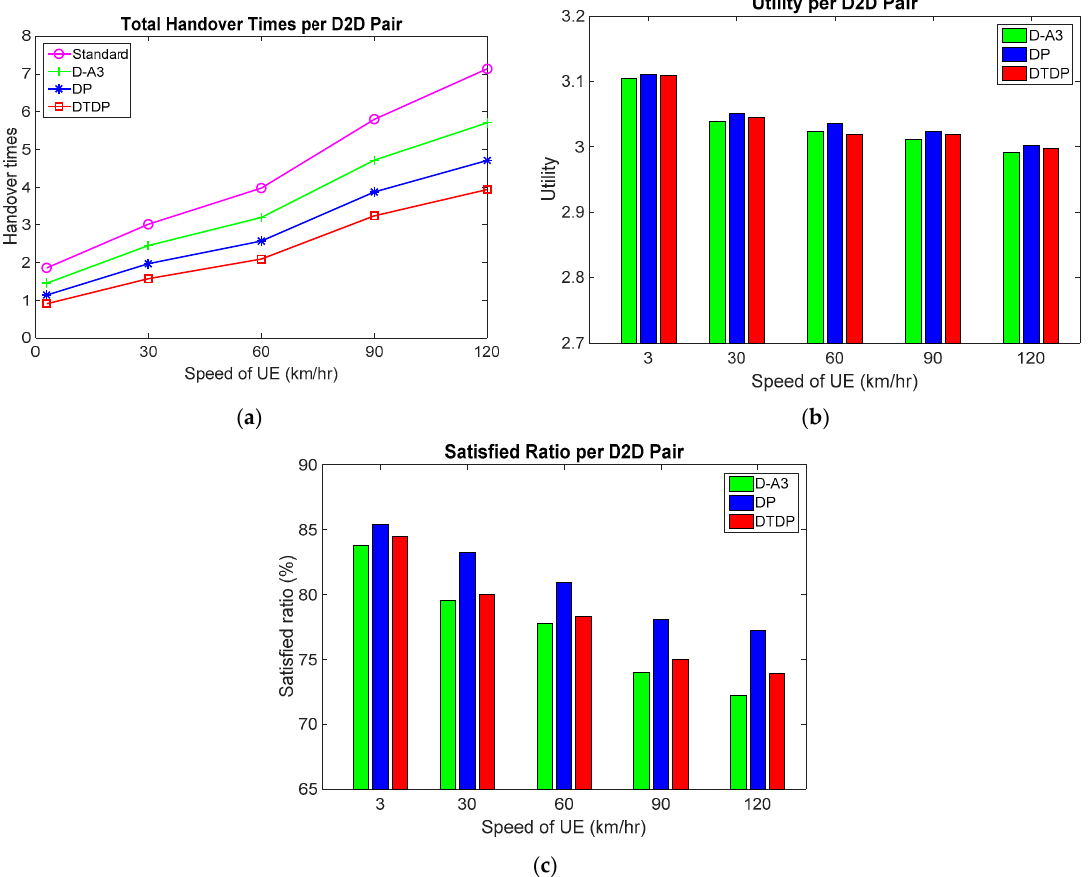
Figure 9. Total number of handovers, utility, and average satisfied ratio for the first D2D pair in the system versus its moving speed. ( a ) Total number of handovers for the first D2D pair. ( b ) Utility for the first D2D pair. ( c ) Average satisfied ratio for the first D2D pair.